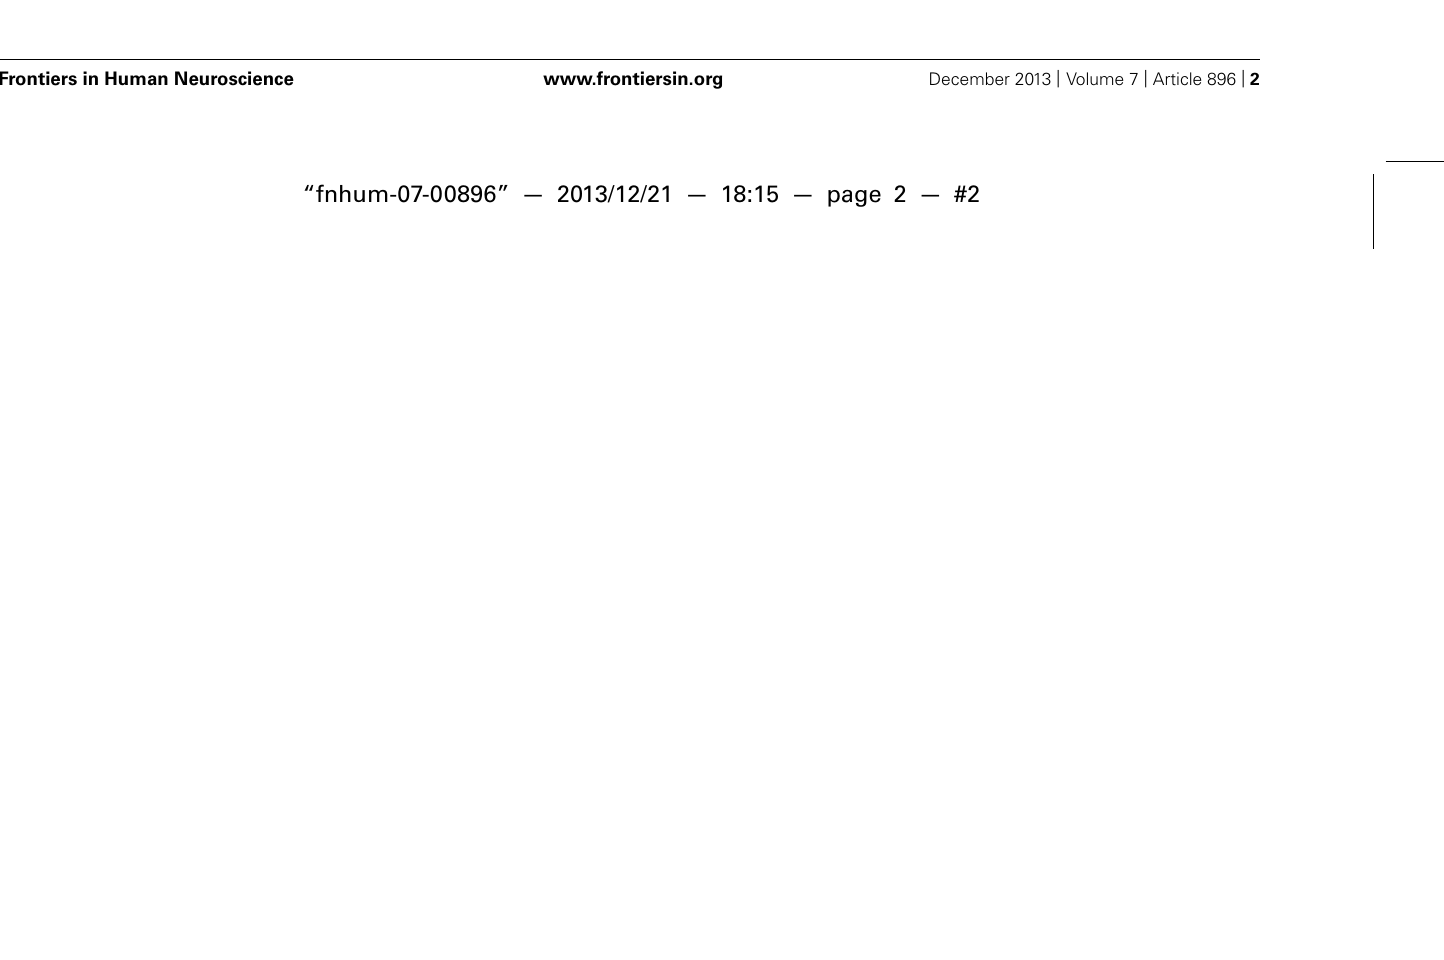
FIGURE 1 | Demonstration of sequence of events in a trial (take fair offer and incongruent information condition as an